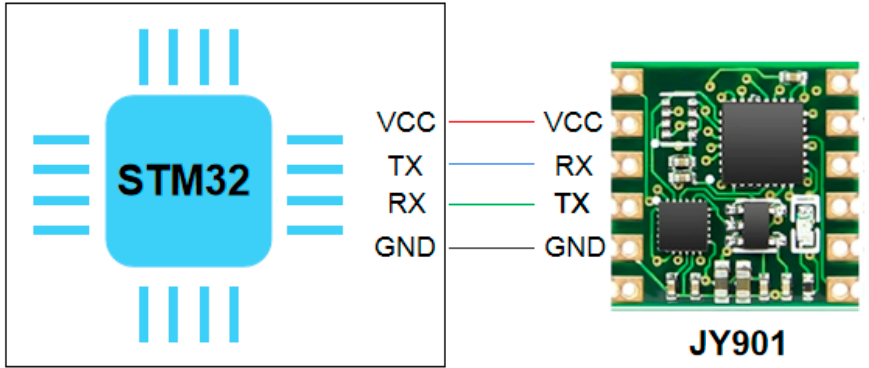
Figure 2. Schematic diagram of inertial sensors (IMU) connected to single chip microcomputer.